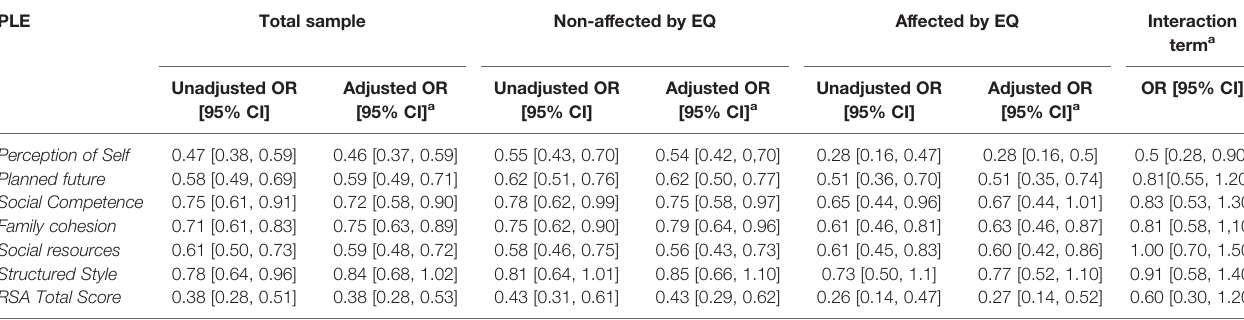
TABLE 4 | Bivariate logistic regression estimates of resilience on psychotic-like experiences (PLEs). PLE Total sample Non-affected by EQ Affected by